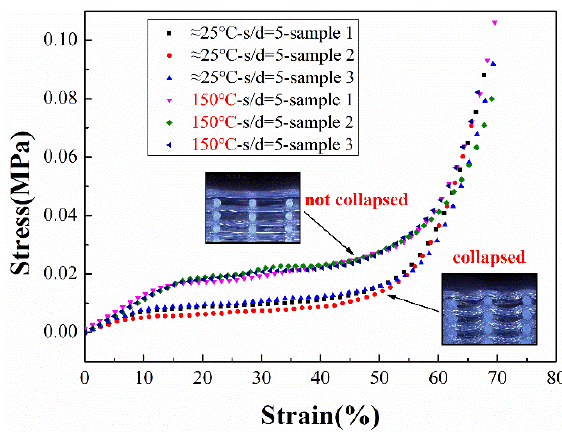
Figure 15. Stress – strain profiles of s/d = 5 samples.